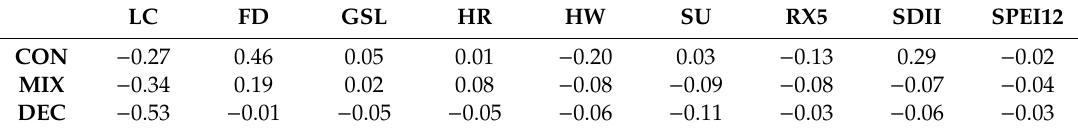
Table 2. Conditional densities of multiple factors on annual average EVI. If conditional density is high, it indicates higher influences on changes in annual average EVI in the study site 1